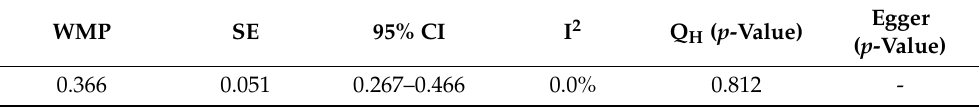
Table 4. Meta-analysis results referring to papilla index grade 3. Caption: WMP = weighted mean prevalence; SE = standard error; CI = confidence interval; QH ( p -value) = Cochrane Q of